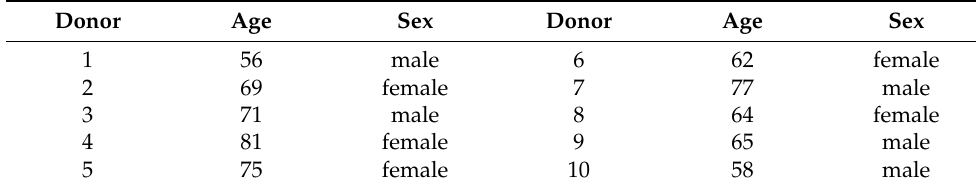
Table 1. Data on age and sex of human MSCs